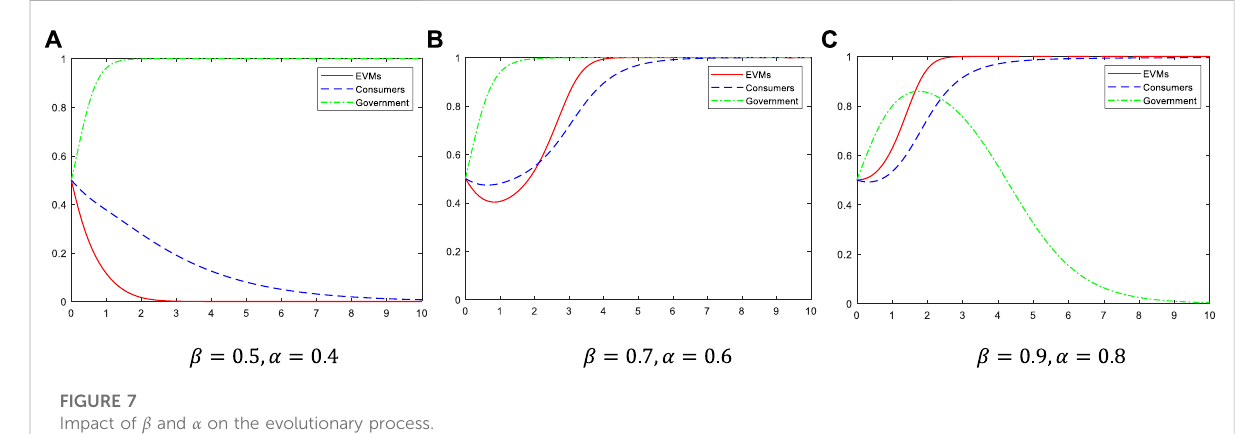
FIGURE 7 Impact of β and α on the evolutionary